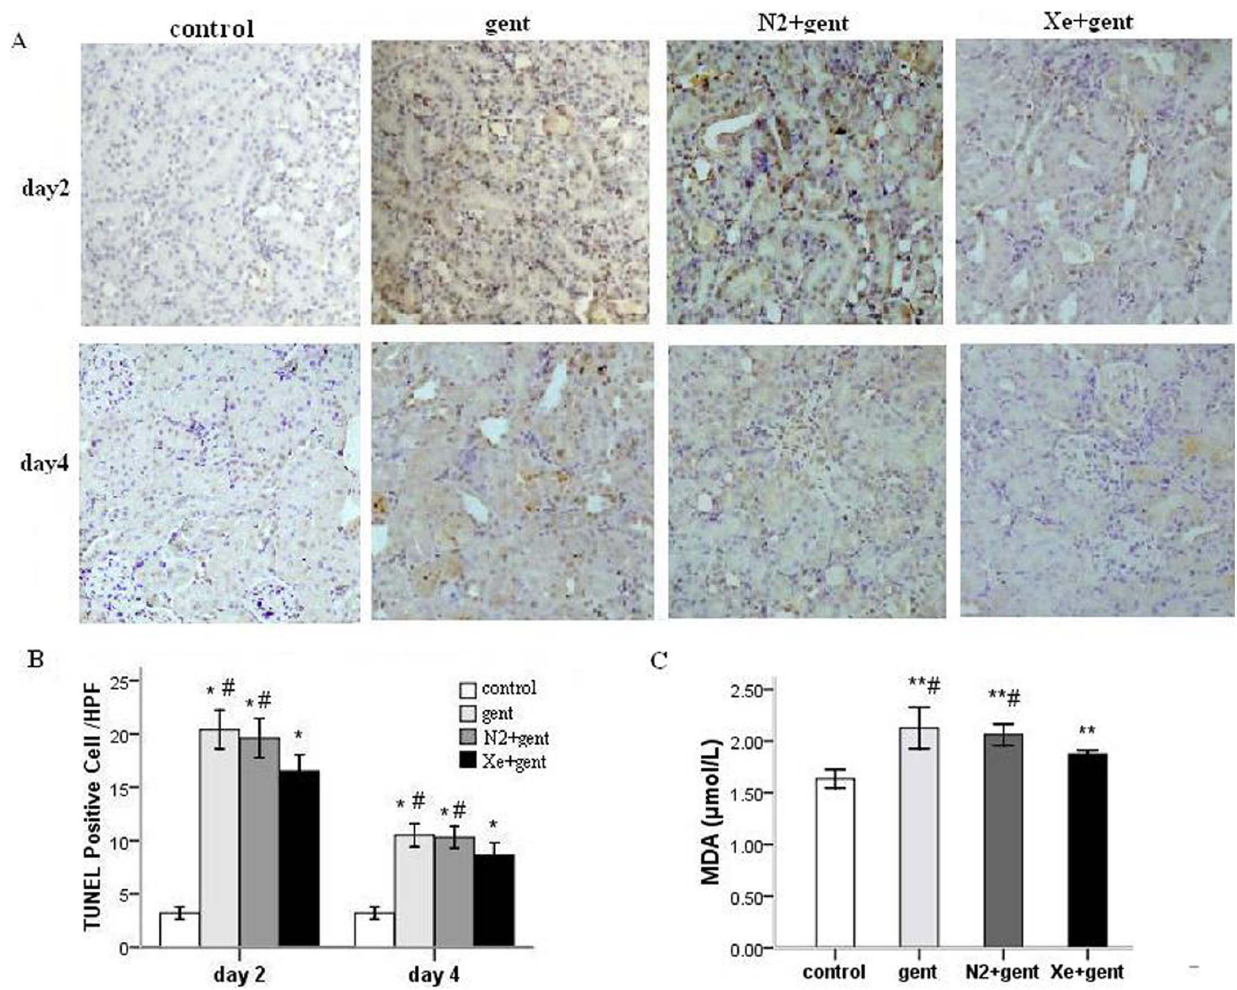
Figure 3. Xenon treatment significantly attenuated cell apoptosis and decreased malondialdehyde (MDA) in the kidney. A: TUNEL- positive cells in renal sections from all groups 2 and 4 days after 7-day gentamicin injection. B: mean value of TUNEL-positive cells in renal sections from all groups. C: MDA concentration in renal tissue 4 days after 7-day gentamicin injection. *P , 0.01, **P , 0.05 vs. control group; # P , 0.05 vs. Xe + gentamicin group, n=6/group at each time point. protocol (In situ Cell Death Detection kit, POD,Roche). The number of TUNEL-positive cells from 10 areas of randomly light microscope.